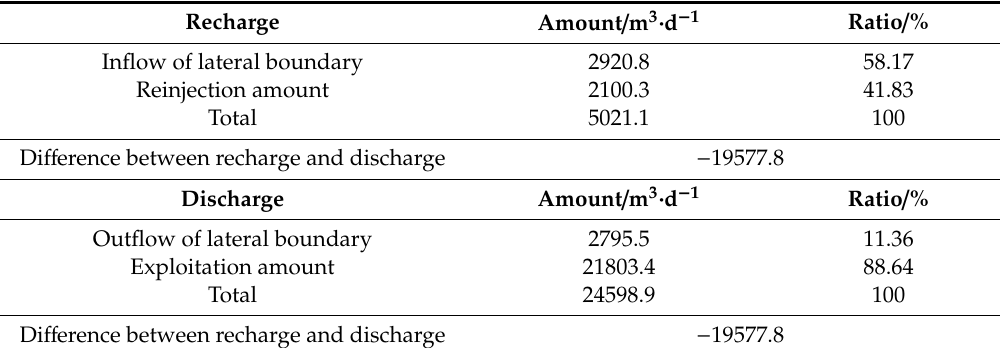
Table 7. Table of average water balance of the study area from 1971 to 2016.